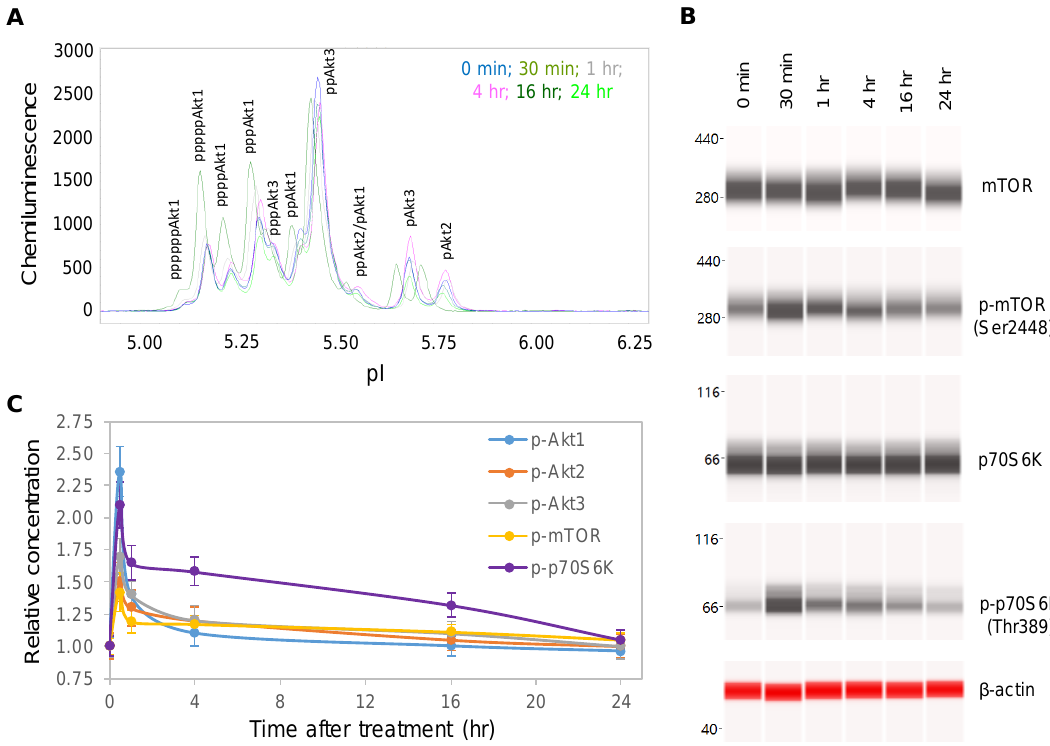
Figure 2. Time-dependent positive regulation of the PI3K / Akt / mTOR signaling pathway by copaiba essential oil. ( A ) Pan-Akt profiles and ( B ) expression levels of the mTOR and p70S6K phosphoisoforms in SH-SY5Y cells as functions of time after treatment. ( C ) Relative concentrations of the Akt1 (blue), Akt2 (orange), Akt3 (gray), mTOR (yellow), and p70S6K (purple) phosphoisoforms in SH-SY5Y cells as functions of time after treatment. The relative concentration describes the fold change in a protein phosphoisoform after treatment compared to the control condition. The error bars are the standard deviations of six repeated measurements per experimental condition. SH-SY5Y cells were treated with 100 ng / mL copaiba essential oil.